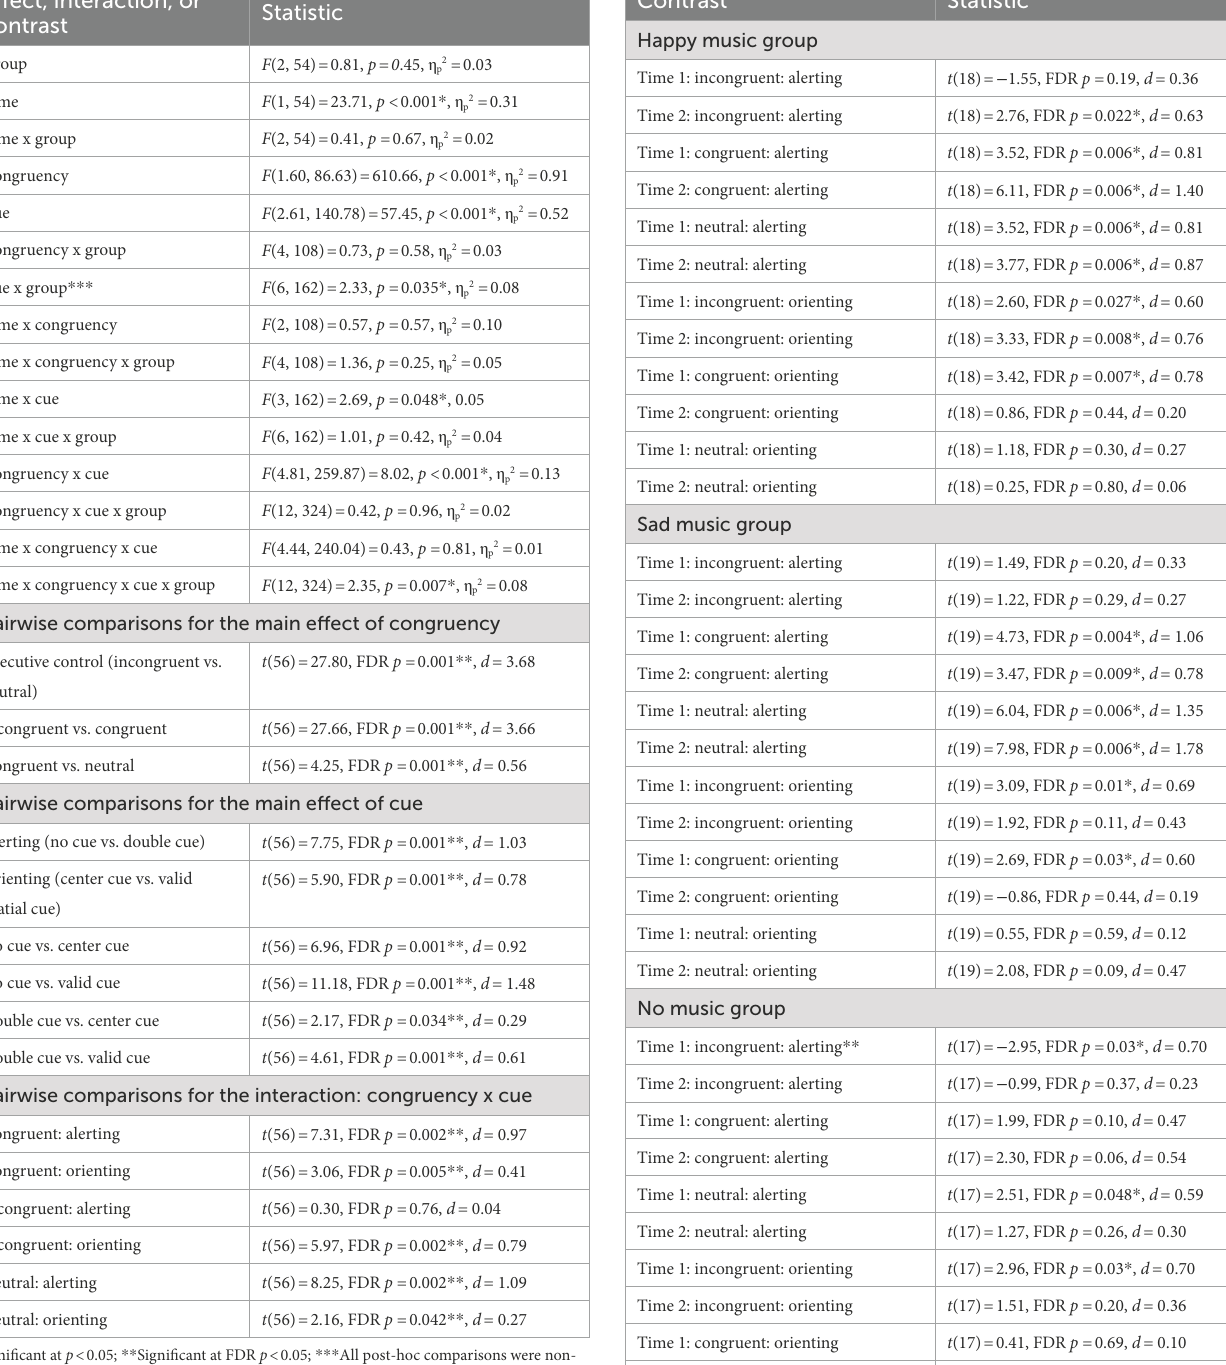
TABLE 5 Post-hoc comparisons within reaction time for the group x time x congruency x cue interaction. Contrast Statistic Happy music